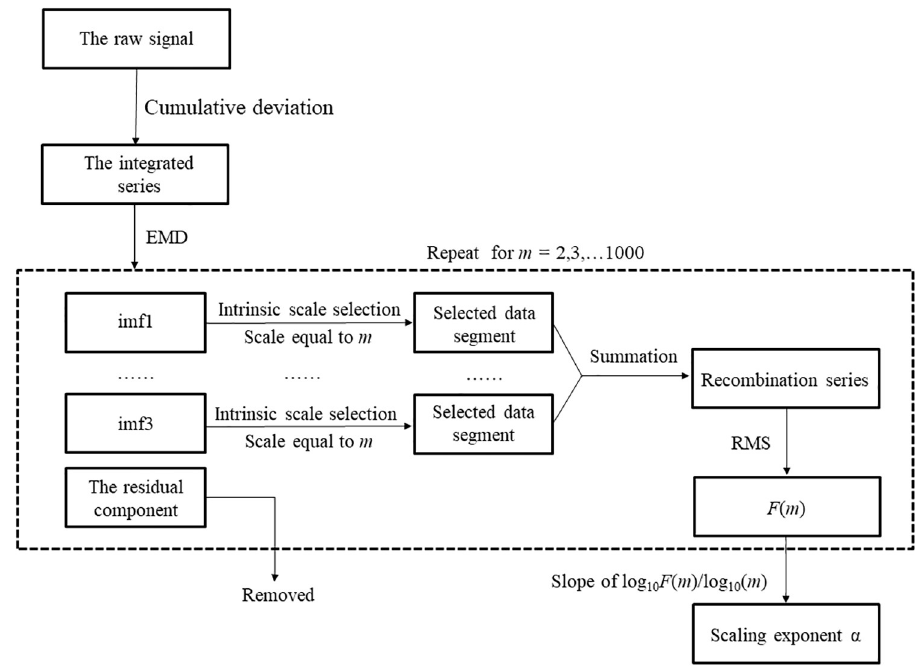
Fig 2. The flow chart of the modified detrended fluctuation analysis with the empirical mode decomposition (EMD-DFA).